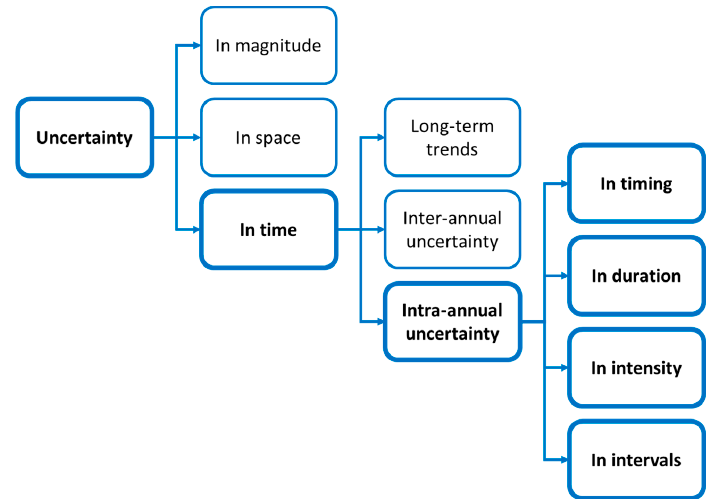
Figure 5. Schematic representation of various types and components of climatic uncertainty. The present article deals with those components shown in bold . present article deals with those components shown in bold